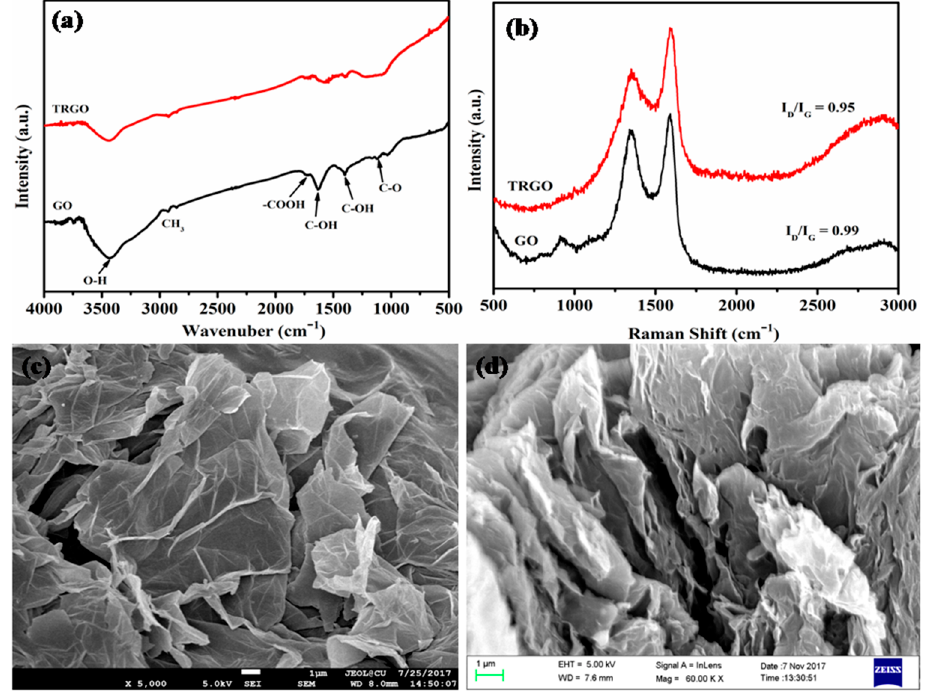
Figure 2. ( a ) FTIR and ( b ) Raman Spectrum and FE-SEM image of ( c ) GO and ( d ) TRGO.